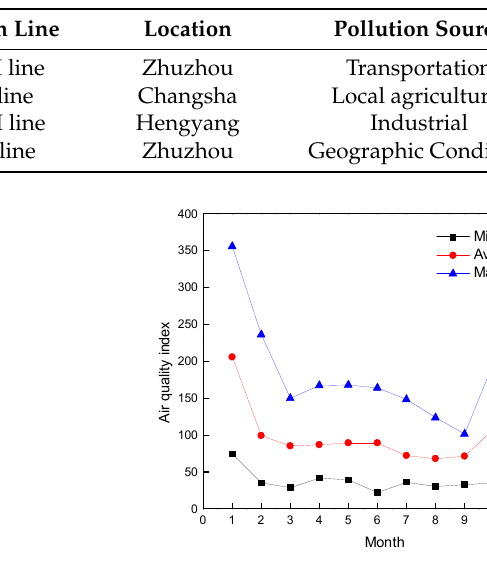
Figure 2. Average air quality index for each month in 2011–2015 (Hunan Province).